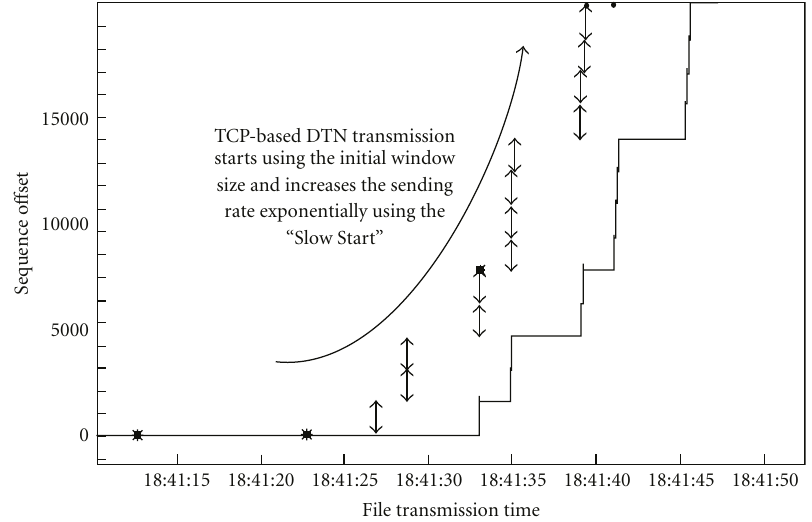
Figure 8: Enlarged view of TSG startup for DTN transmission from MX to RX over cislunar channels with link delay of 3000 ms and link disruption of 4 hours at BER = 10 − 6